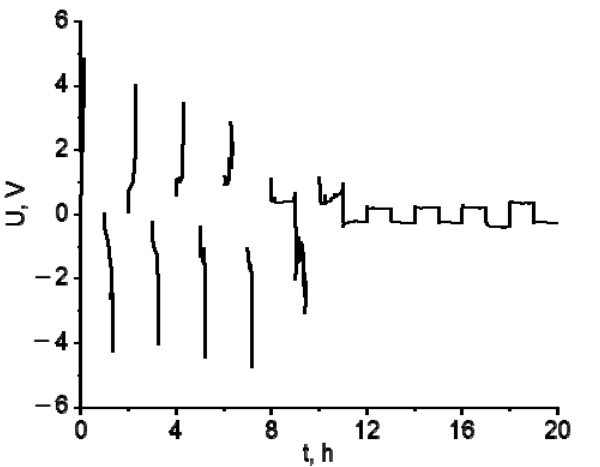
Figure 6. Galvanostatic cycling data of the Li-In (40 at% Li) | LLZcomp | Li-In (40 at% Li) symmetric cell with the applied current of ±1 mA at 200 °C. Micrographs of the cross-section of the Li-In|LLZcomp|Li-In cells with